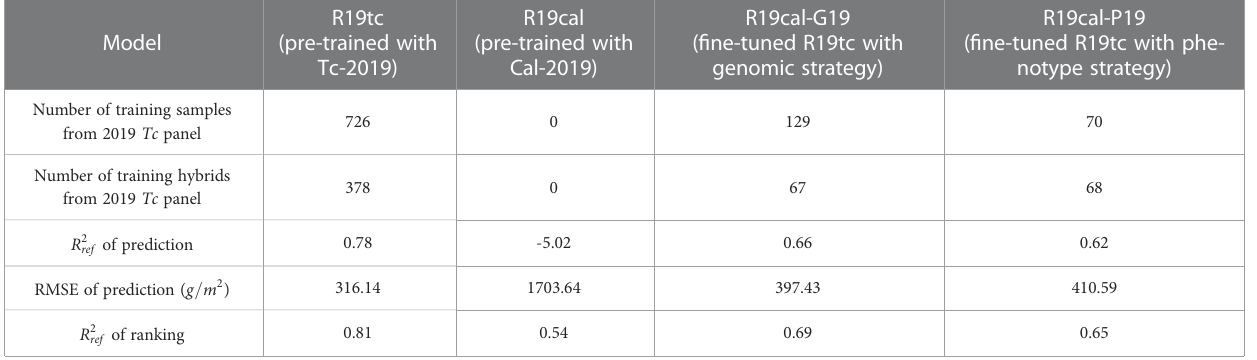
TABLE 3 Biomass prediction results obtained by the 4 models on the Tc and Cal panels in 2019.